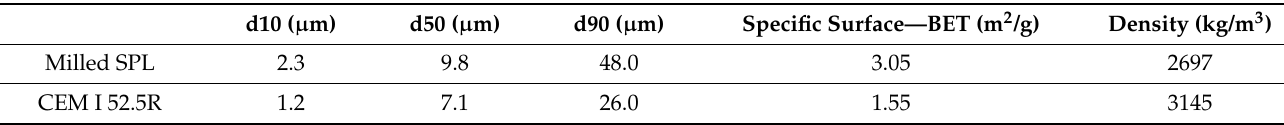
Table 5. Physical properties of the milled spent pot lining aluminosilicates. Particle size distribution by laser diffraction, BET specific surface by nitrogen sorption and the true density from He-pycnometry.